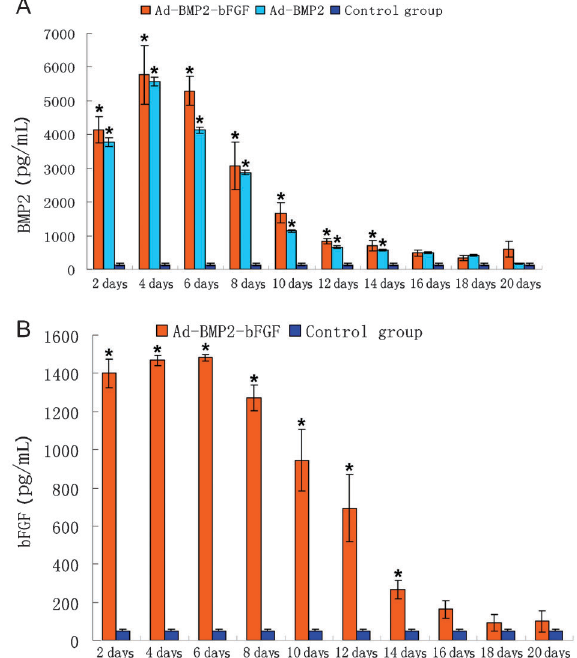
Figure 5. Expression of bone morphogenetic protein 2 (BMP-2) and basic fibroblast growth factor (bFGF) in bone marrow progenitor cells (BMPCs). A , ELISA assay of BMP2 level secreted by BMPCs at different days after infection. B , ELISA assay of bFGF level secreted by BMPCs at different days after infection. Data are reported as means±SD (n=3). *P , 0.05 vs control